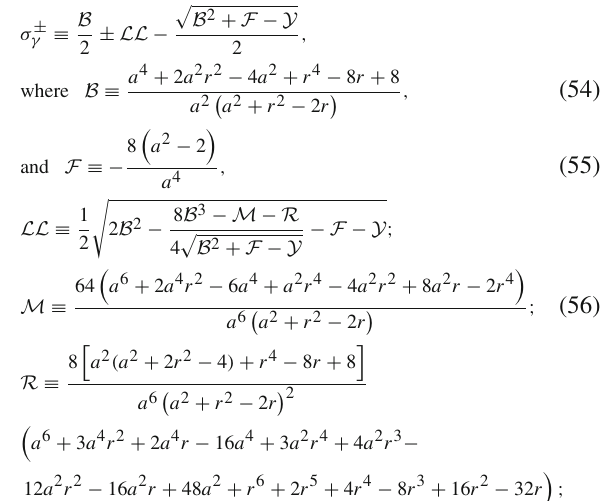
or σ = 1) which is clear also from the orbits in Fig.